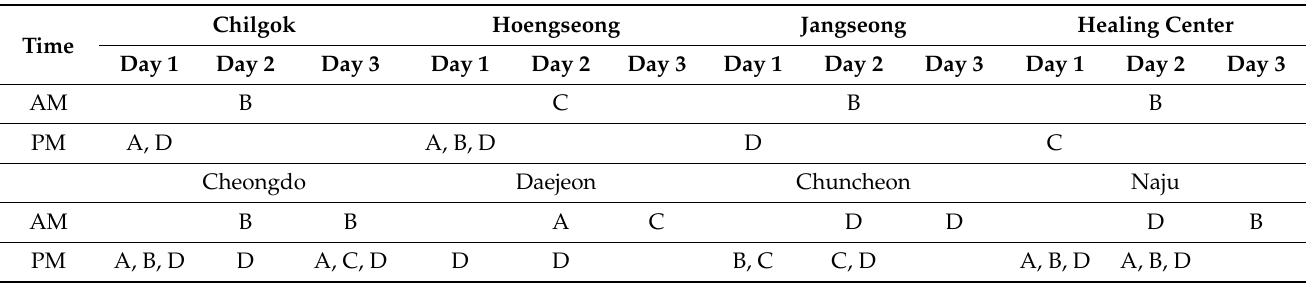
Table 4. Schedule of forest healing programs for two nights and three days for each institution in